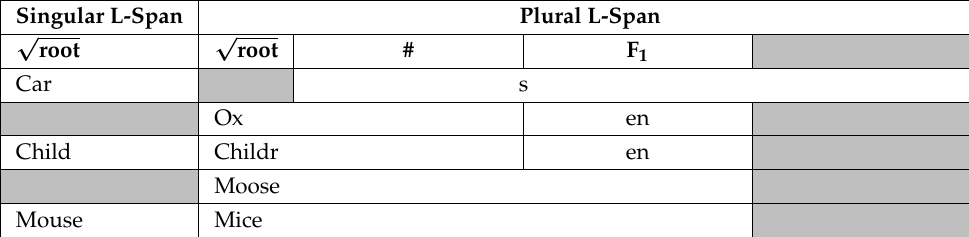
Table 5. Stored features in Singular